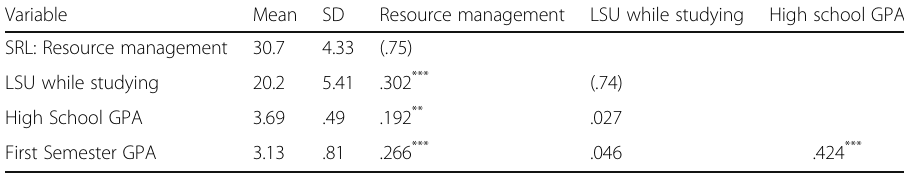
Table 2 Means, standard deviations, correlations, and Cronbach ’ s alpha (parentheses in matrix diagonal) for all variables